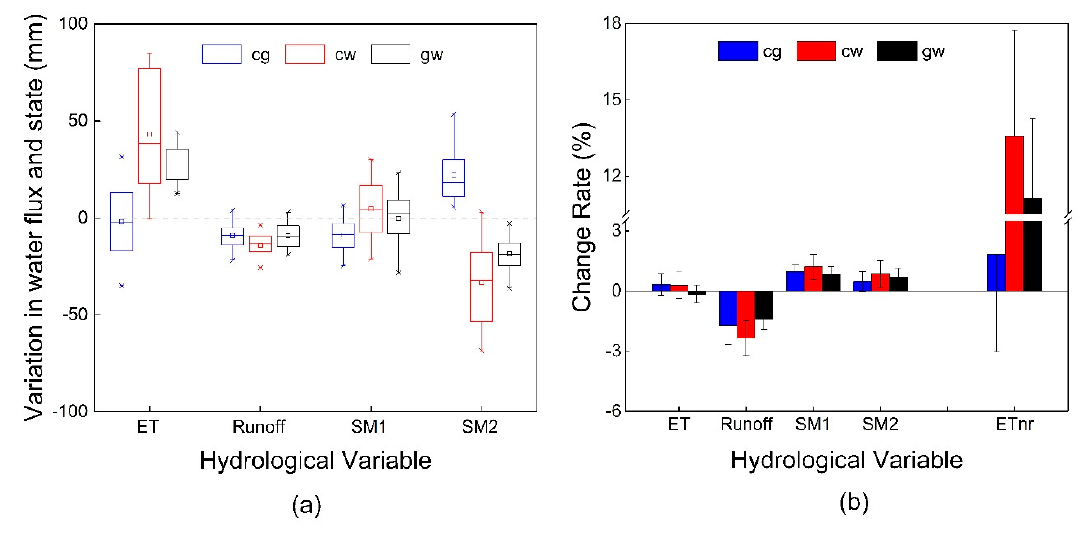
Figure 9. Impact of three typical vegetation conversion modes on the four key HVs. ( a ) Variations in multi-year mean value of water flux and state, ( b ) change rate of HVs in rainfall and non-rainfall days, before and after conversions, during the period 2000–2015.